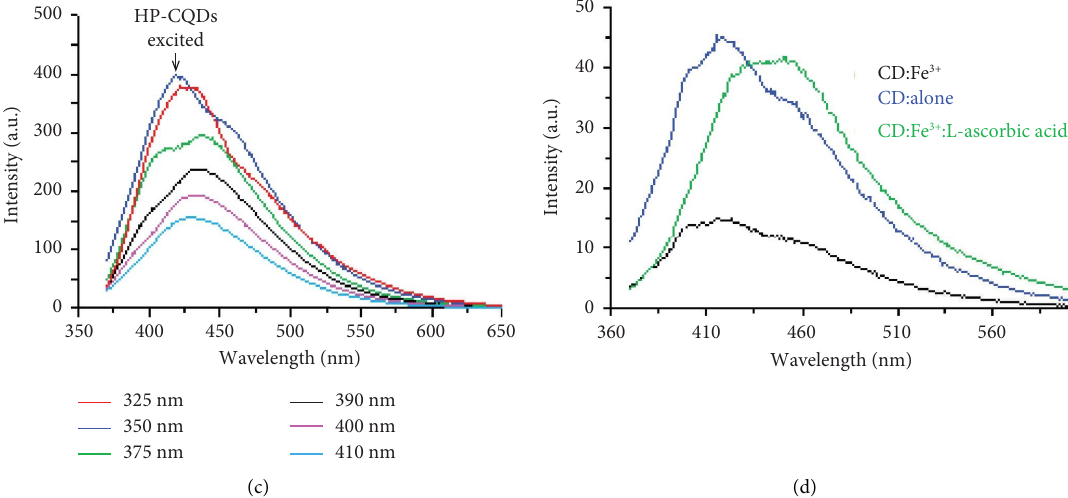
Figure 3: (a) UV-vis absorbance spectrum of HP-CQDs in the solution. (b) Absorbance and emission spectrum of HP-CQDs; the excited wavelength was 350 nm. (c) Fluorescence spectrum at diferent excitation wavelengths. (d) Fluorescence spectra of HP-CQDs (alone), HP- CQDs: Fe 3+ , and HP-CQDs: Fe 3+ -L-ascorbic acid.